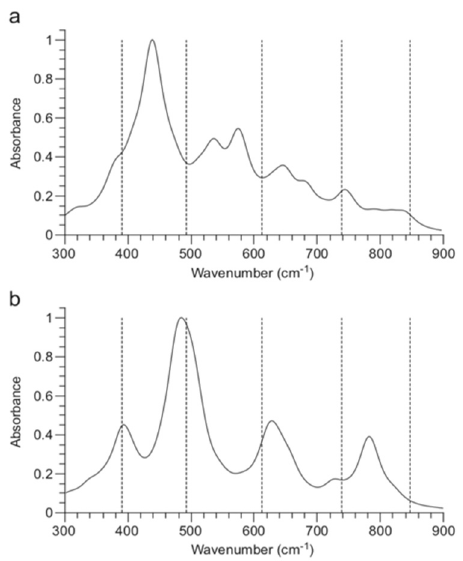
Figure 5. Simulated IR spectra for ( a ) non-spinel and ( b ) defect spinel structures, dashed black lines are experimental frequencies. Reprinted from the Journal of Solid State Chemistry, Vol 184 Issue 5,